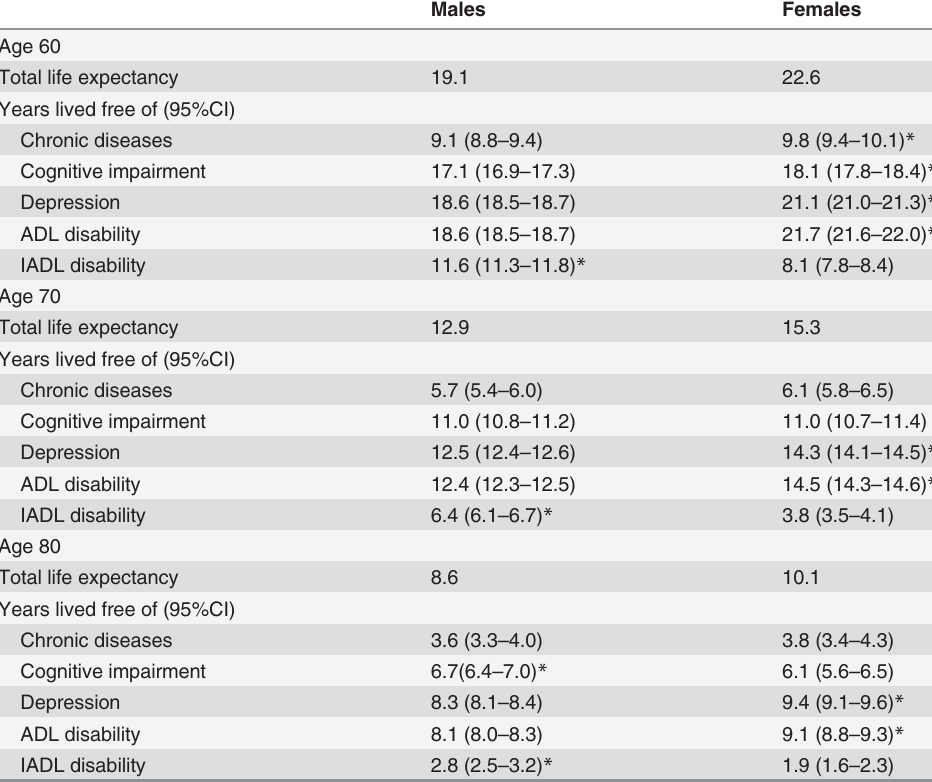
Table 3. Total life expectancy and number of years lived free of morbidity and disability at age 60, 70, and 80 by genders in Thailand,